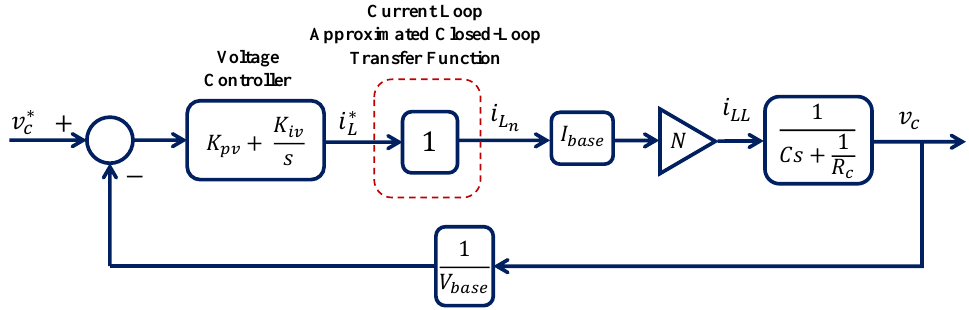
Figure 8. Approximated voltage control loop with the current control closed-loop transfer function as a unitary gain.